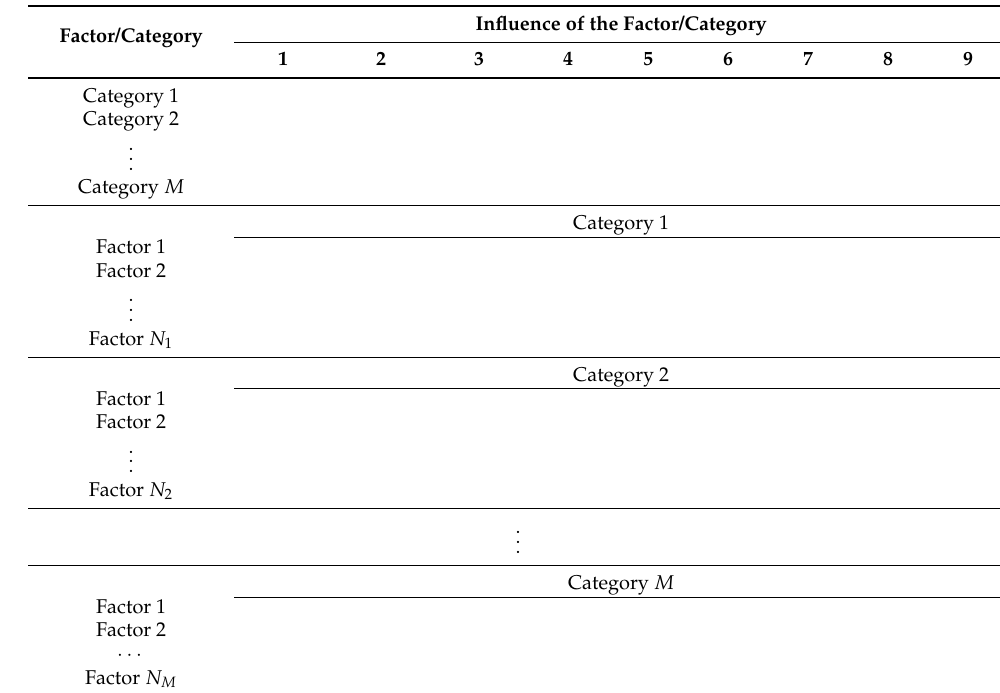
Table 2. Questionnaire template for determining fire risk factor weight distribution. ( M is the number of categories; N 1 , N 2 , · · · , N M represent the number of factors belong to each